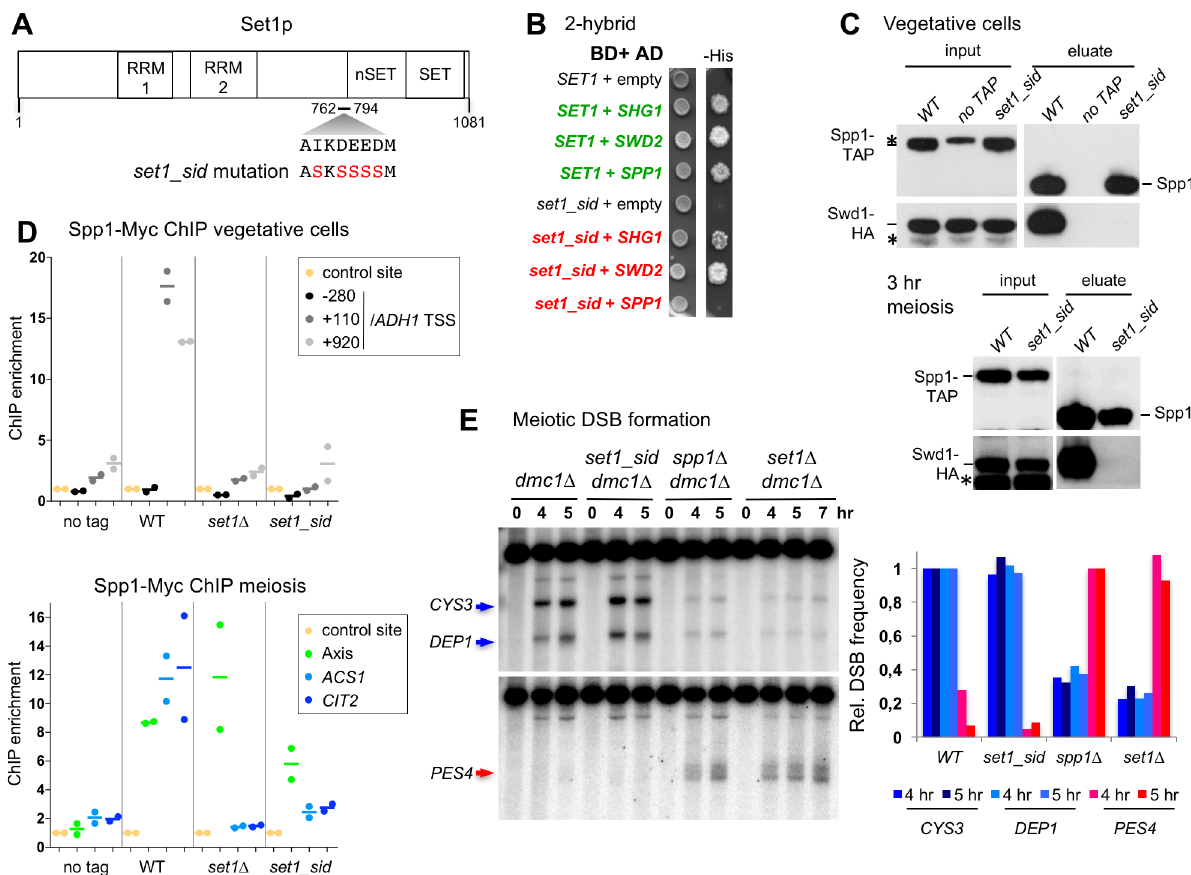
regulatory domains [64] and the mutations creating the set1_sid mutant. (B) 2-hybrid assays for the interaction between Set1 and Spp1. Growth on the–His medium indicates an interaction between the two tested proteins. (C) Interaction of Spp1 with the Set1 complex subunit Swd1 in vegetative or meiotic cells examined by Western blot as indicated. Proteins pulled down by Spp1-TAP were released in the eluate after Tev cleavage of the TAP tag. Anti-HA and anti-TAP antibodies were used. The TAP antibody still recognizes the part of the tag left after Tev cleavage. SET1 SPP1-TAP SWD1-HA :VBD1745; SET1 SWD1-HA :VBD1742; set1_sid SPP1-TAP SWD1-HA :VBD1836. The asterisk indicates non-specific cross-hybridizing band. (D) Binding of Spp1 detected by ChIP-qPCR in vegetative cells or in meiotic cells at t = 3 hr. No tag: ORD7339; WT: VBD1187; set1 Δ : VBD1209; set1_sid :VBD1868. Each dot represents a biological replicate and the bar indicates the mean. (E) Meiotic DSB formation monitored in dmc1 Δ cells by Southern blot at CYS3 and DEP1 DSB (upper panel), or at the spp1 Δ -specific PES4 DSB (lower panel). DSB sites are indicated by an arrow. WT: ORD7354; set1_sid :VBD1854; spp1 Δ :VBD1748; set1 Δ :ORD9624. Graph shows the DSB quantification relative to the level in WT (for CYS3 , DEP1 ) or spp1 Δ cells (for PES4 site). DSB were quantified at the 5 hr time point, with the additional 7 hr time point for set1 Δ